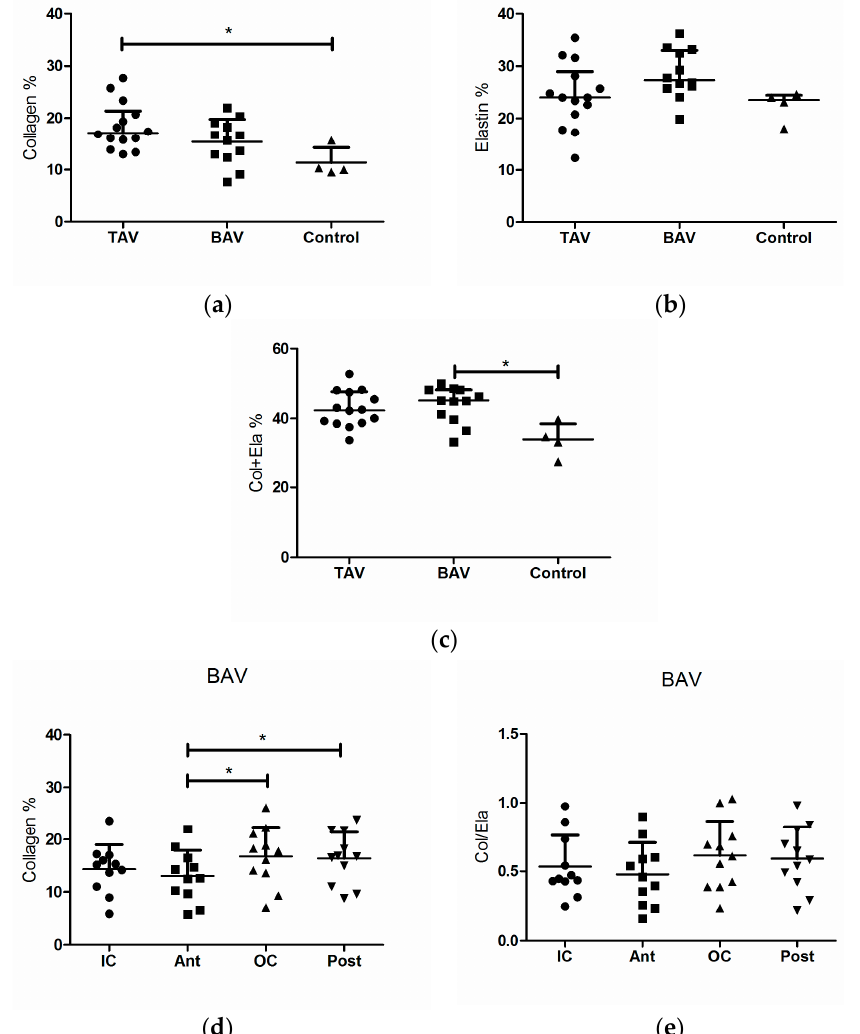
Figure 4. ( a ) Average collagen is dependent on groups ( p = 0.0257); ( b ) Average elastin is dependent on groups ( p = 0.0271); ( c ) The average content of collagen and elastin varies amongst the groups ( p = 0.0260) (Kruskal-Wallis and Dunn’s multiple comparisons post-test); the images depict the median and interquartile. For the BAV group: ( d ) collagen depends on region ( p = 0.0075); and ( e ) Col/Ela ( p = 0.0458) (one-way ANOVA with repeated measure and Bonferroni’s multiple comparisons post-test). Asterisks denote significant difference: * p < 0.05.